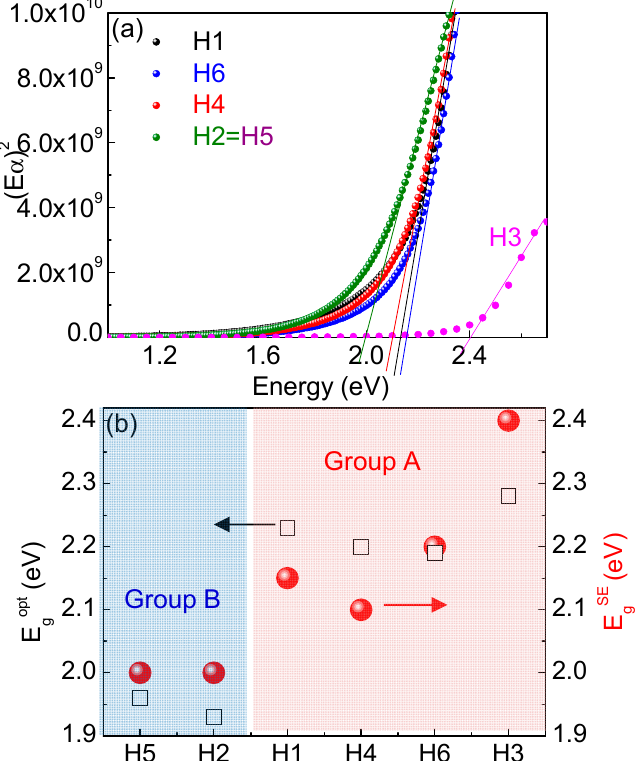
Figure 5. ( a ) (E α ) 2 vs.energy of different molecules and ( b ) comparison between gaps calculated from ellipsometry ( E opt g ) and by absorption measurements ( E SE g ) .